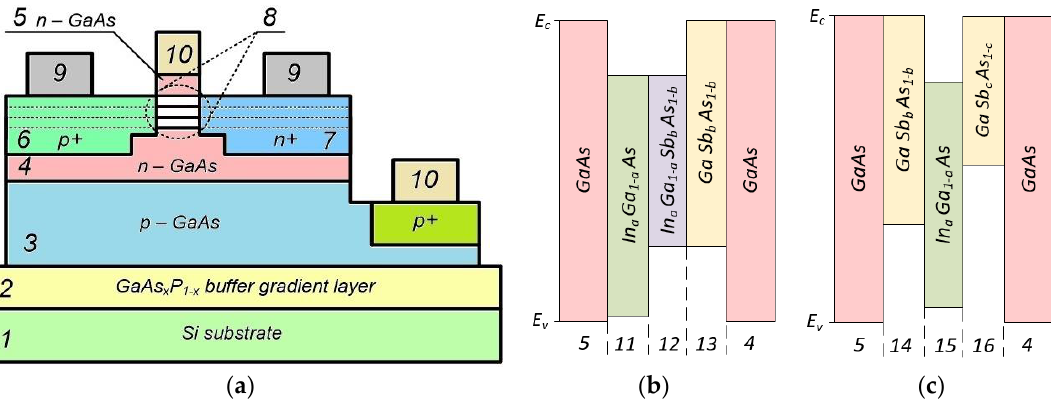
Figure 2. The cross-section of the laser-modulator ( a ): 1, silicon substrate of IC; 2, GaAs x P 1 − x gradient buffer layer; 3, p-GaAs layer; 4, 5, n-GaAs layers; 6, 7, highly doped p + and n + regions; 8, nanoheterostructure of the integrated amplitude ( b ) or frequency ( c ) modulator; 9, power contacts; 10, control contacts [31–34]. Energy band diagram of the amplitude modulator ( b ) contains quantum wells in conduction (layers 11, 12) and valence (layers 12, 13) bands. The spatial overlap of quantum wells is located in layer 12. Layers 11, 13 are the regions of quantum well’s space division. Energy band diagram of the frequency modulator ( c ) includes two quantum wells with different depths in valence band (14 and 16) and one quantum well in conduction band (15).